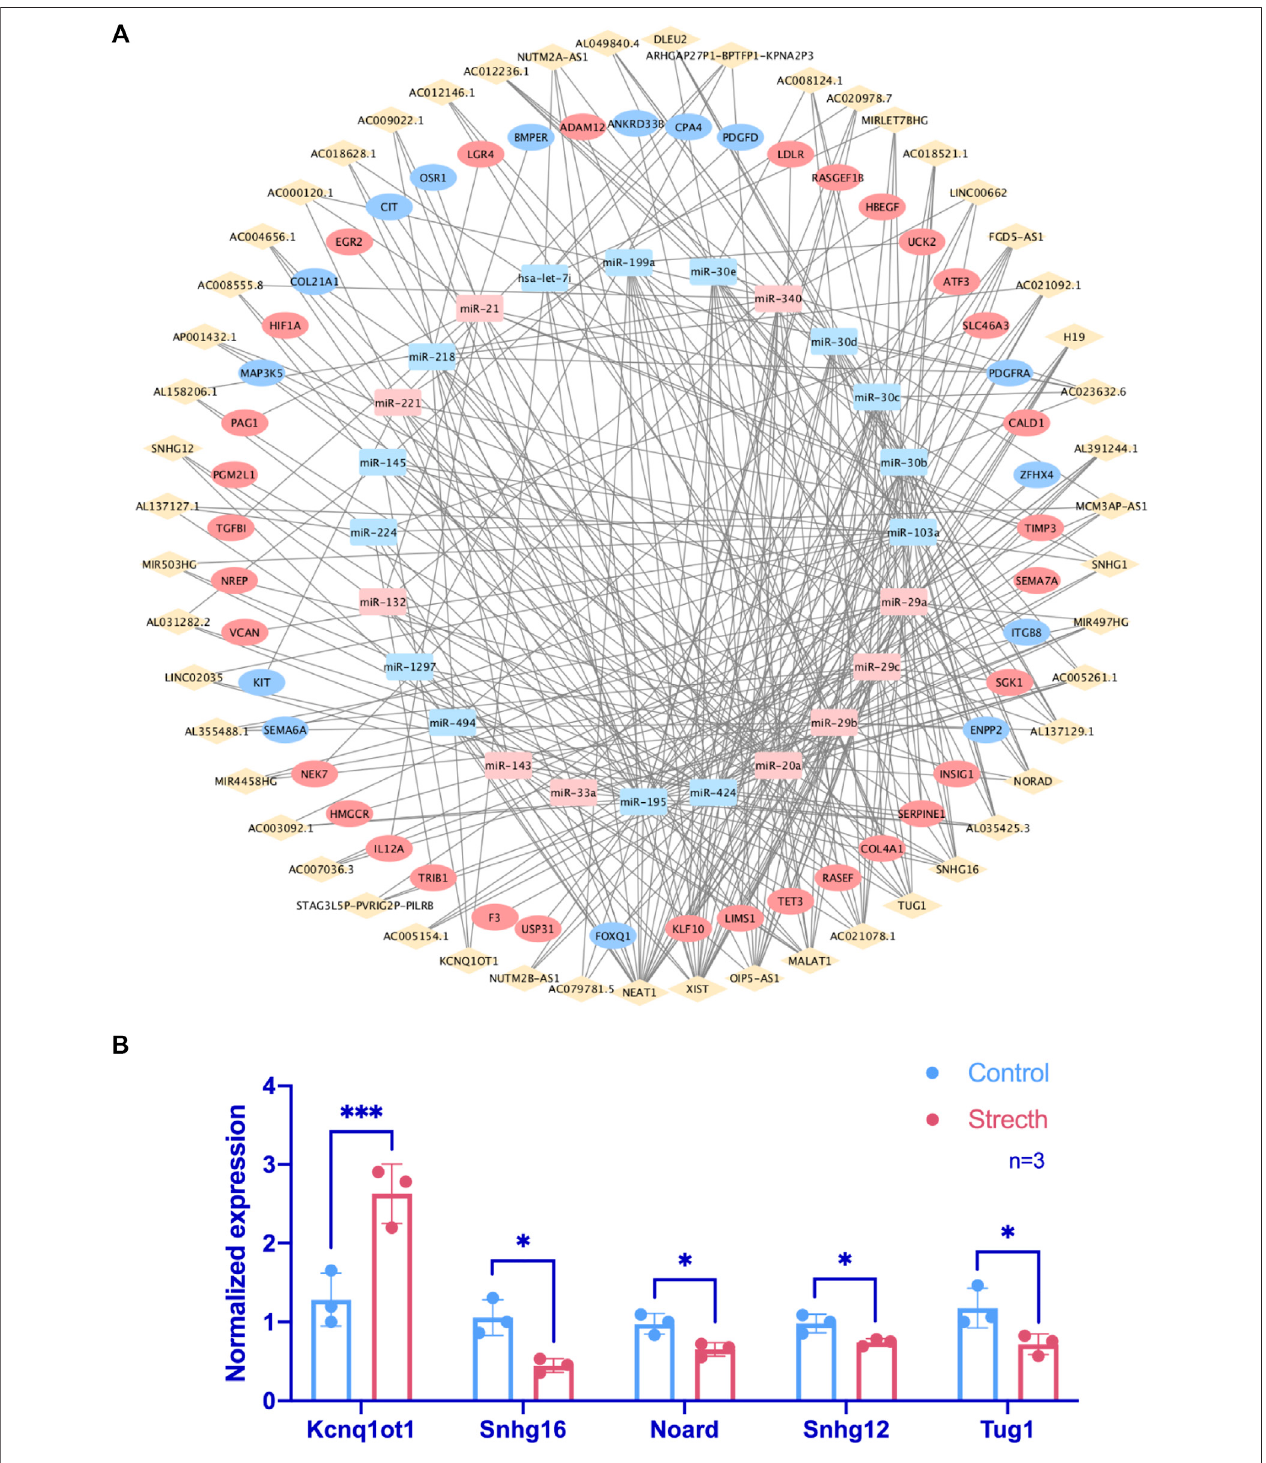
FIGURE 4 | Identi fi cation of FR lncRNA through the ceRNA network and RT-qPCR validation. In the ceRNA network, rhombuses, squares, and circles stand for lncRNAs, miRNAs, and mRNAs, respectively. Upregulated RNAs are shown in pink, while downregulated ones are shown in blue. Gray lines represent regulatory relationships (A) . The validation of lncRNA expression changes via RT-qPCR under mechanical stretch was normalized to Gapdh ( n = 3) (B) .